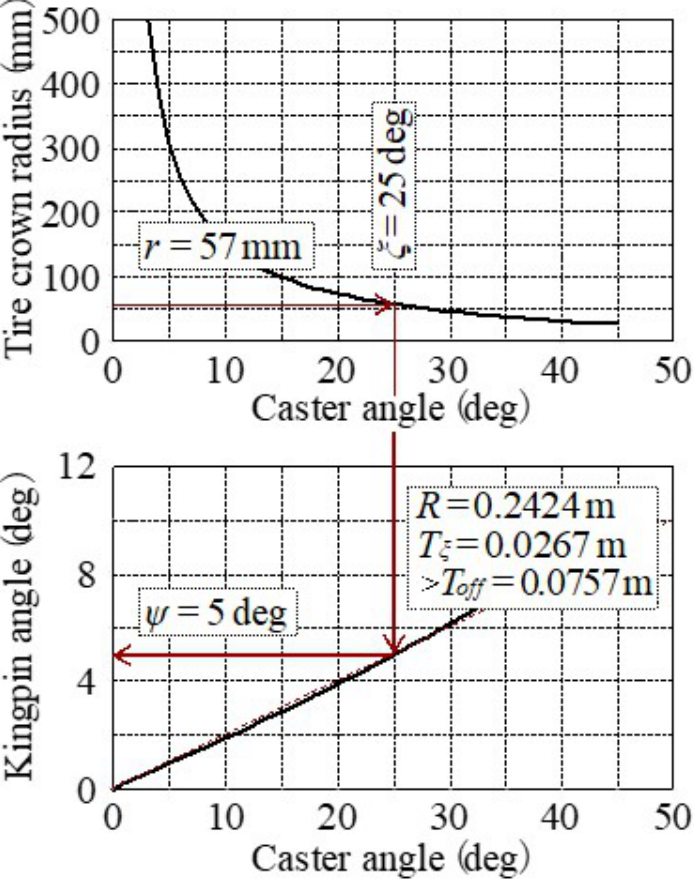
Figure 13. Procedure to set the steering